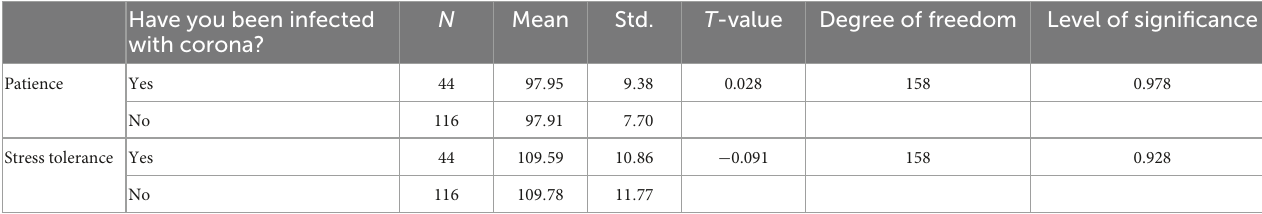
No 116 TABLE 5 Results of t -test for variance in total means of the level of patience and stress tolerance, due to working with COVID patients. Do you work with COVID N Mean Std. T -value Degree of freedom Level of patients